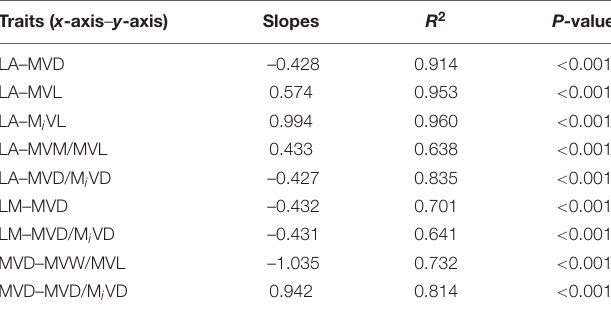
TABLE 2 | The regression slopes between functional traits (log-log transformed data) of correlated evolutionary divergences for 39 subtropical woody plants in Tiantong National Forest Park, China.